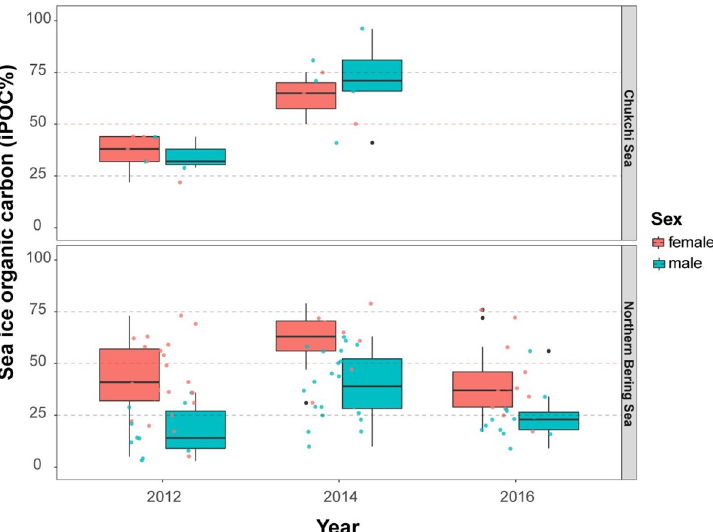
Fig 5. Sea ice organic carbon by region and sex for 2012, 2014 and 2016 (NBS only). The boxplot indicates the interquartile range from the first to third quartiles, with the median shown as the horizontal line within each box for females and males for each region. All individual data points are shown. The red-dashed line indicates 50% sea ice organic carbon utilization, with values above this level suggesting elevated sea ice organic